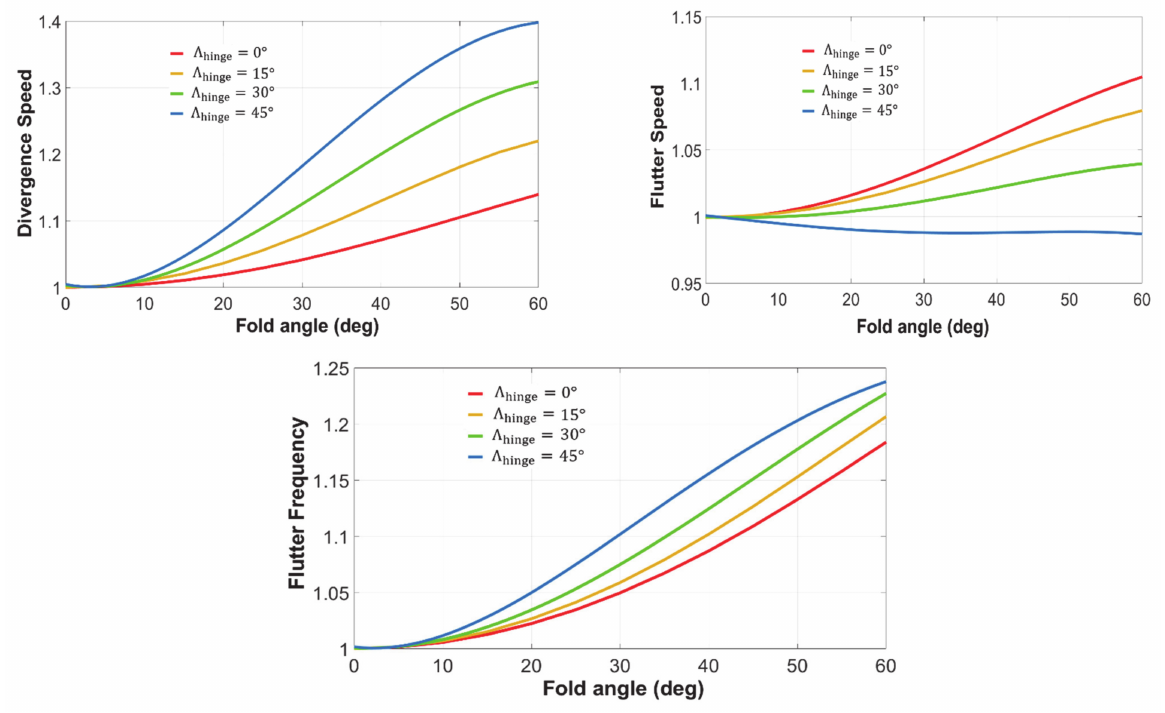
Figure 6. Variation of aeroelastic parameters for an outboard segment length of 1.016 m.